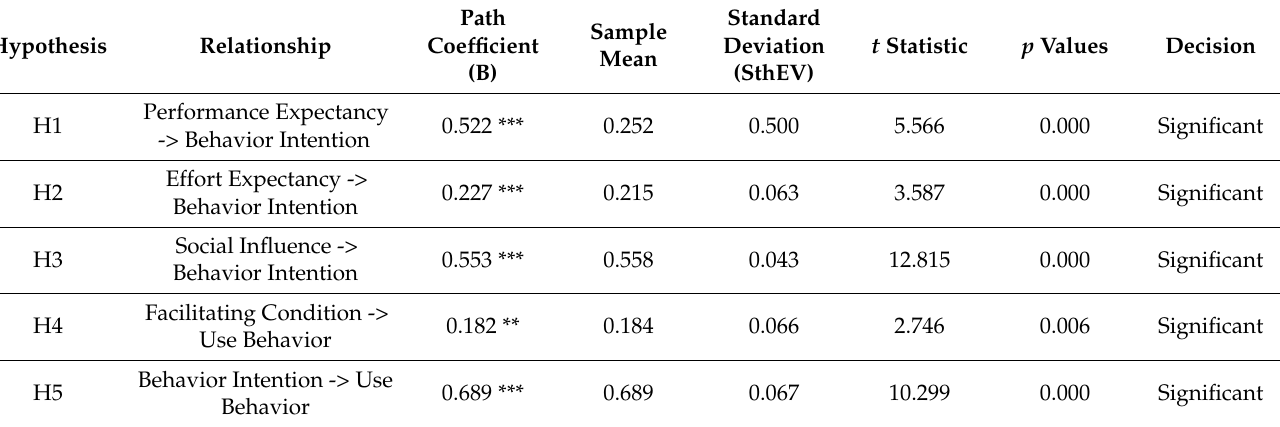
Table 8. Hypothesis testing of factors affecting the use of